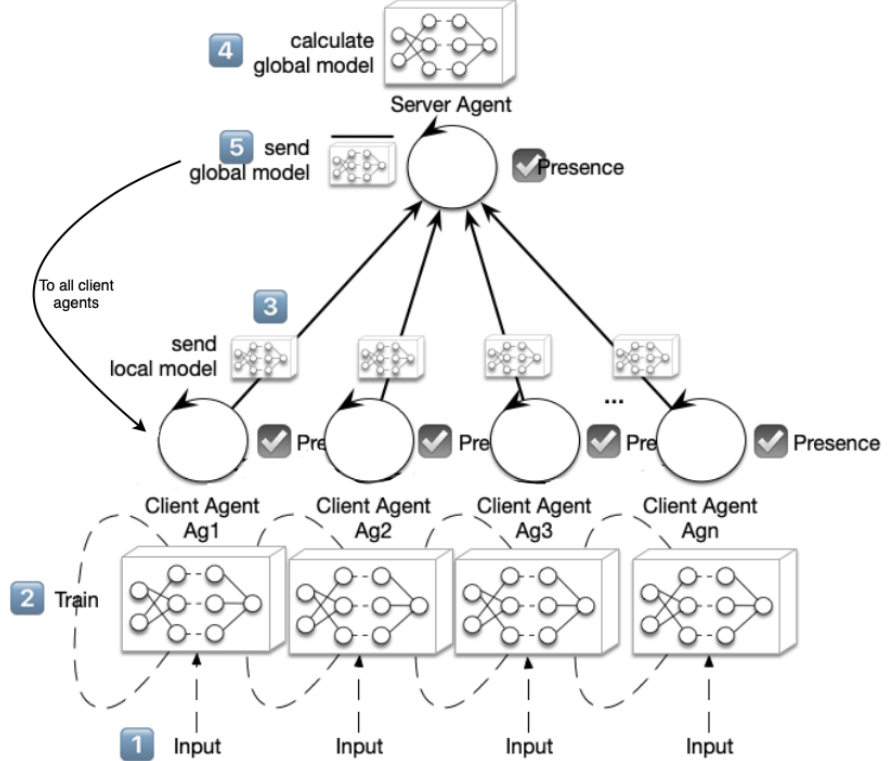
Figure 4. FLaMAS framework description.